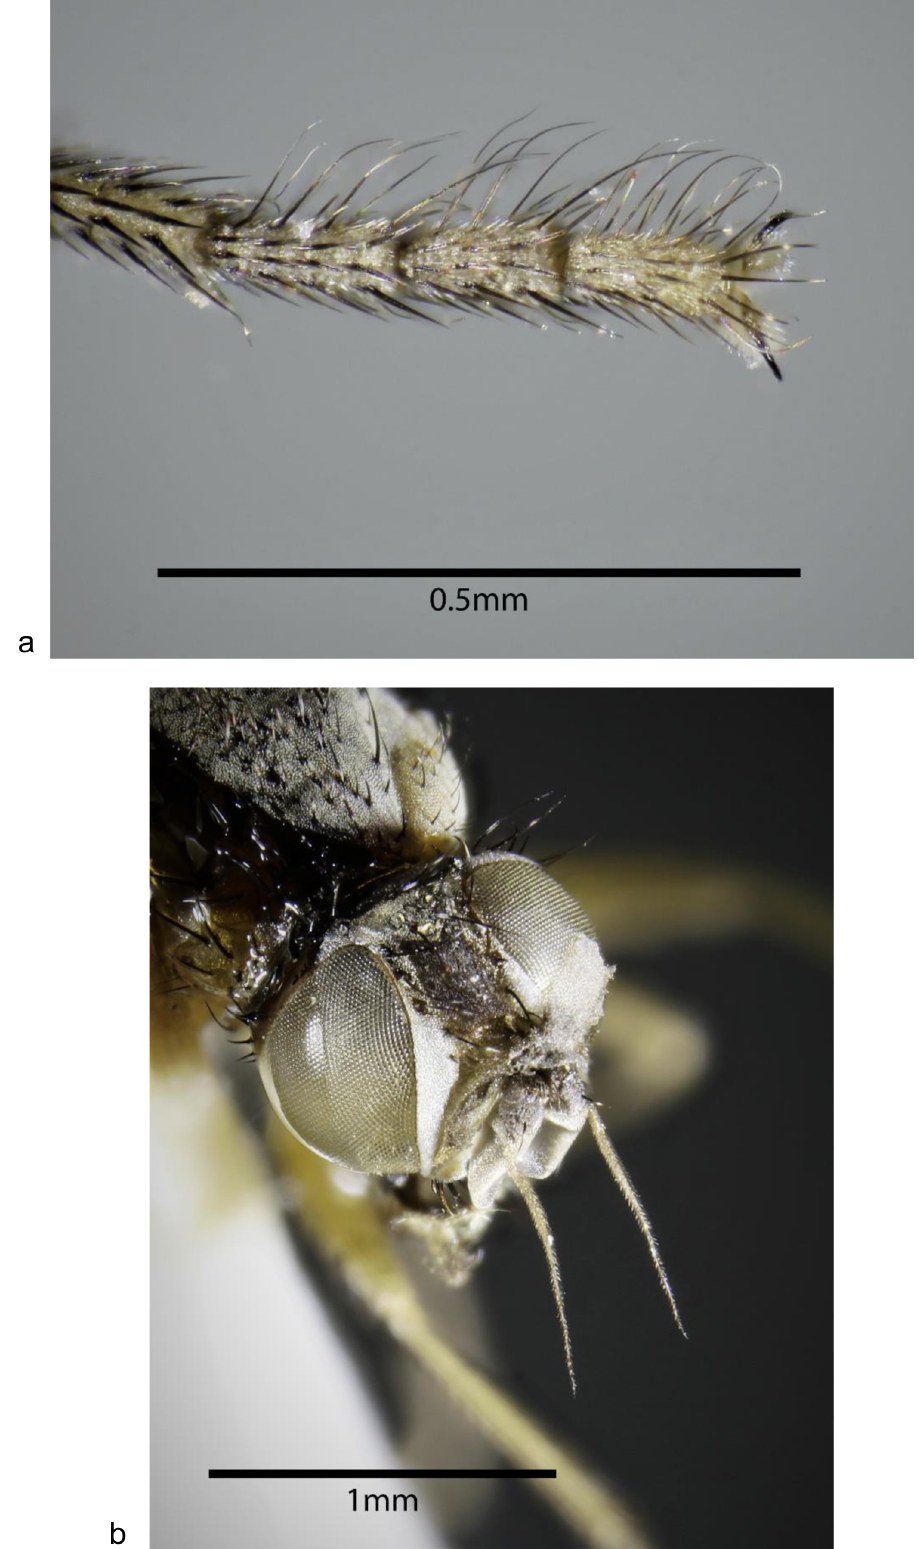
Fig. 6. Atherigona zongoi sp. nov., paratype, ♂ (NMWC). a . Head, anterior oblique view. b . Fore tarsus, dorsal